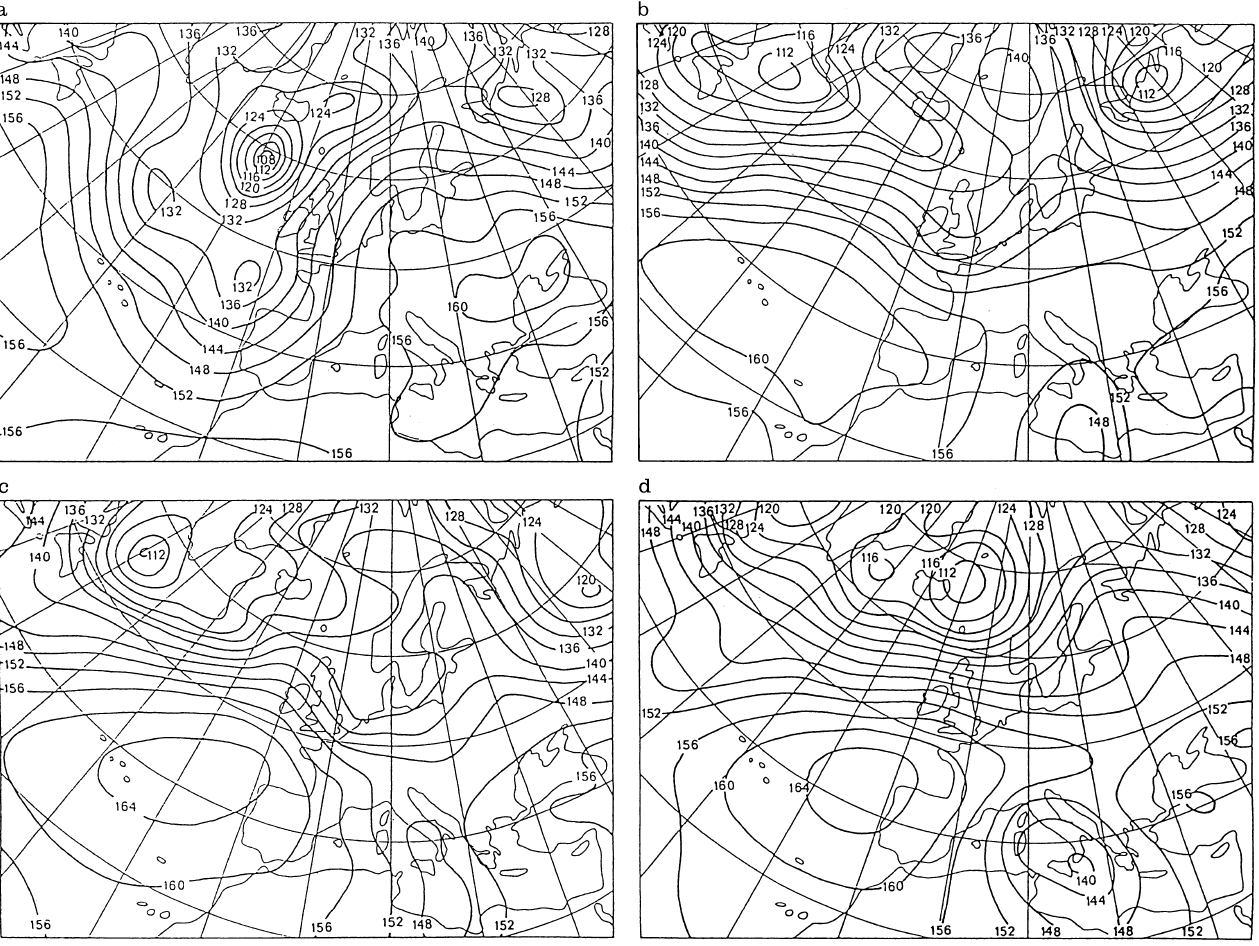
Fig. 3a–d. Synoptic field of the geopotential (in tens of meters) at 850 hPa for the 4 mountain wave cases: a 15/10/90; b 14/11/90; c 15/11/90; d 16/11/90 at 00:00